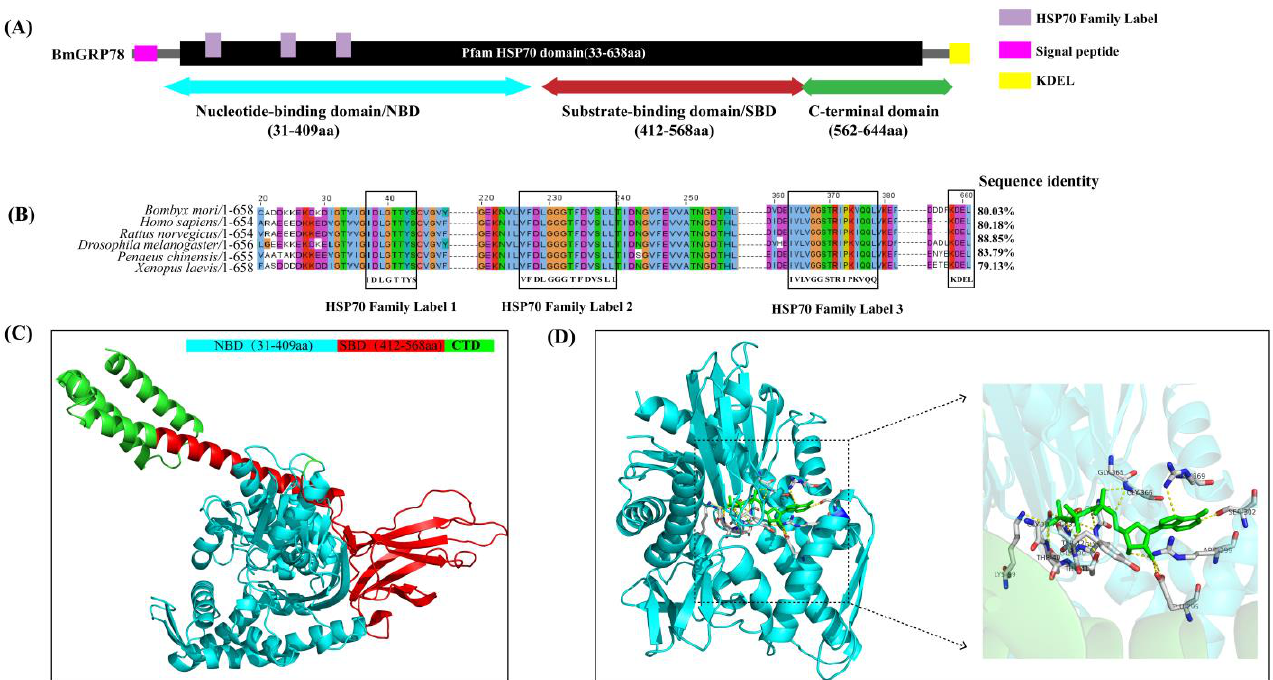
Figure 1. The domains, comparison, and predicted three-dimensional structure of the BmGRP78. ( A ) The upper panel represents the primary structure of BmGRP78, including the nucleotide binding domain (NBD), substrate binding domain (SBD), and C-terminal domain. In addition to the NBD and SBD, BmGRP78 also has an amino-terminus signal sequence, which is a 20-amino acid long signal peptide for ER targeting and translocation, and a carboxy-terminus ER retrieval sequence, lys-asp-glu-leu (KDEL), which prevents BmGRP78 from being secreted from the ER. ( B ) The middle panel shows a comparison of the BmGRP78 sequence of the species. ( C ) The predicted three-dimensional structure of the three domains in BmGRP78. The protein is represented by cartoons colored cyan (NBD), red (SBD), and green (C-terminal). The numbers represent the start and end of amino acid residues of the BmGRP78 domains. The models were generated by SWISS-MODEL, using Human GRP78 as the template (PDB ID 6asy1). ( D ) The NBD domain with the ATP molecule (PDB ID 5F1X) is represented by the green cartoon. The green stick represents the ATP that binds to the NBD of BmGRP78. The binding site with ATP is enlarged to show the amino acids involved in the interaction. The PyMol 2.4 software is used to represent the entire figure. (For interpretation of the references to color in this figure legend, the reader is referred to the web version of this article.)